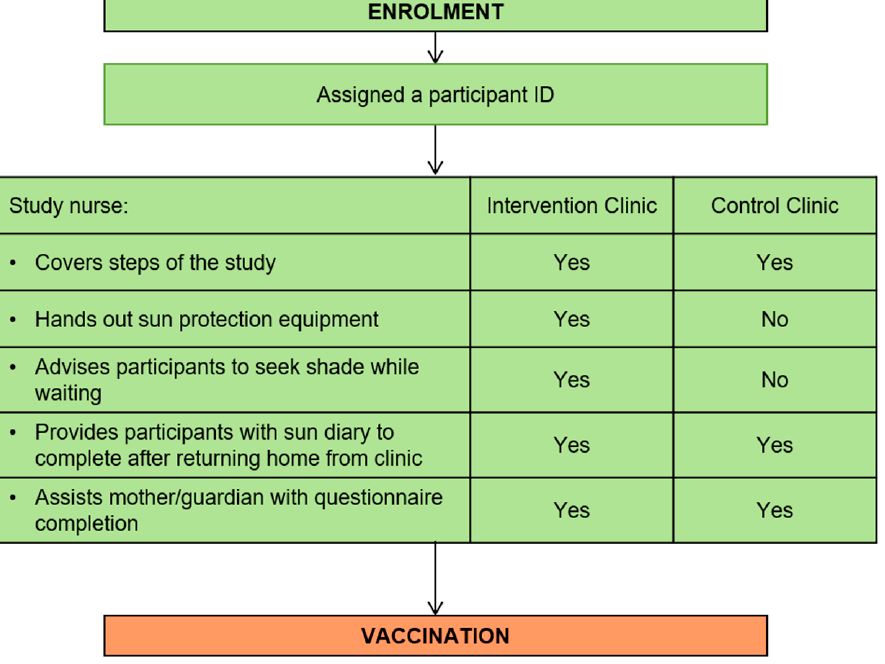
Figure 4. Enrolment stage flow chart.